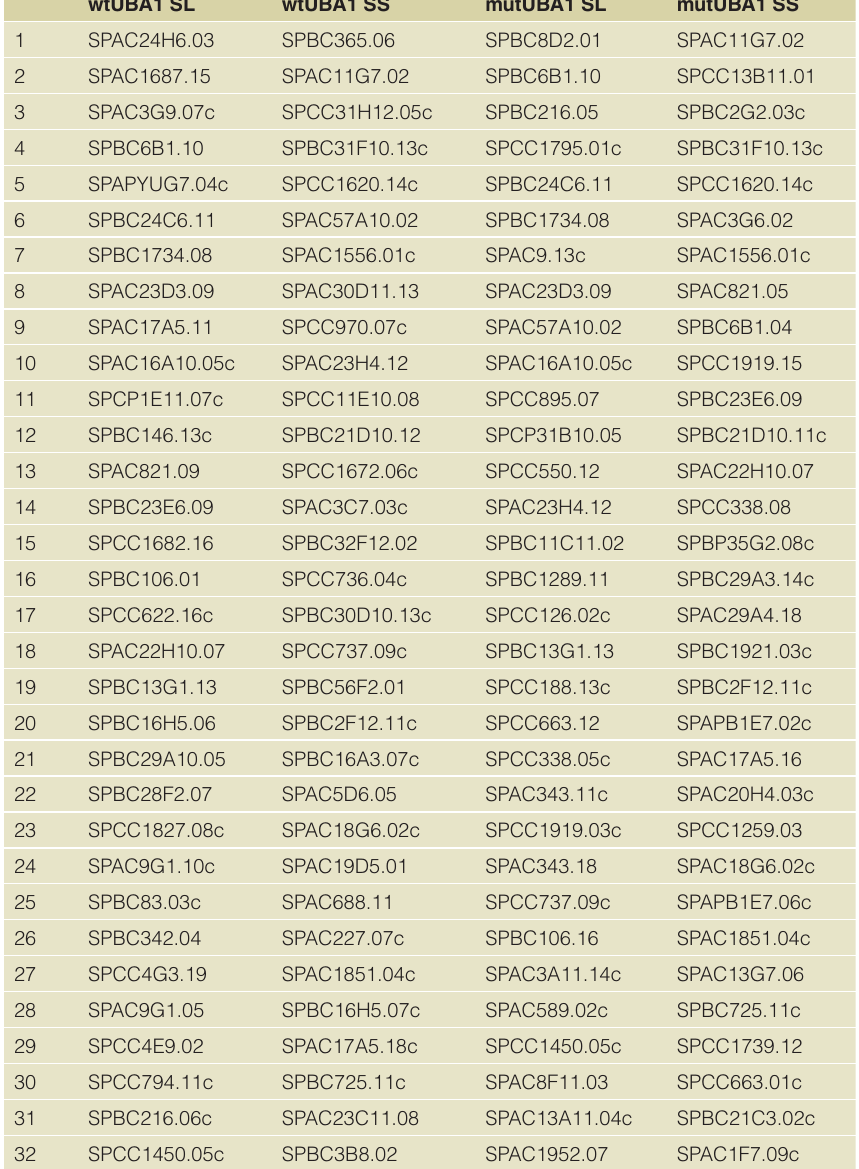
Table 1. S. pombe SGA top hits. The tops hits for wtUBA1 SL, wtUBA1 SS, mutUBA1 SL, and mutUBA1 SS were identified by bioinformatic analysis as described in the materials and methods